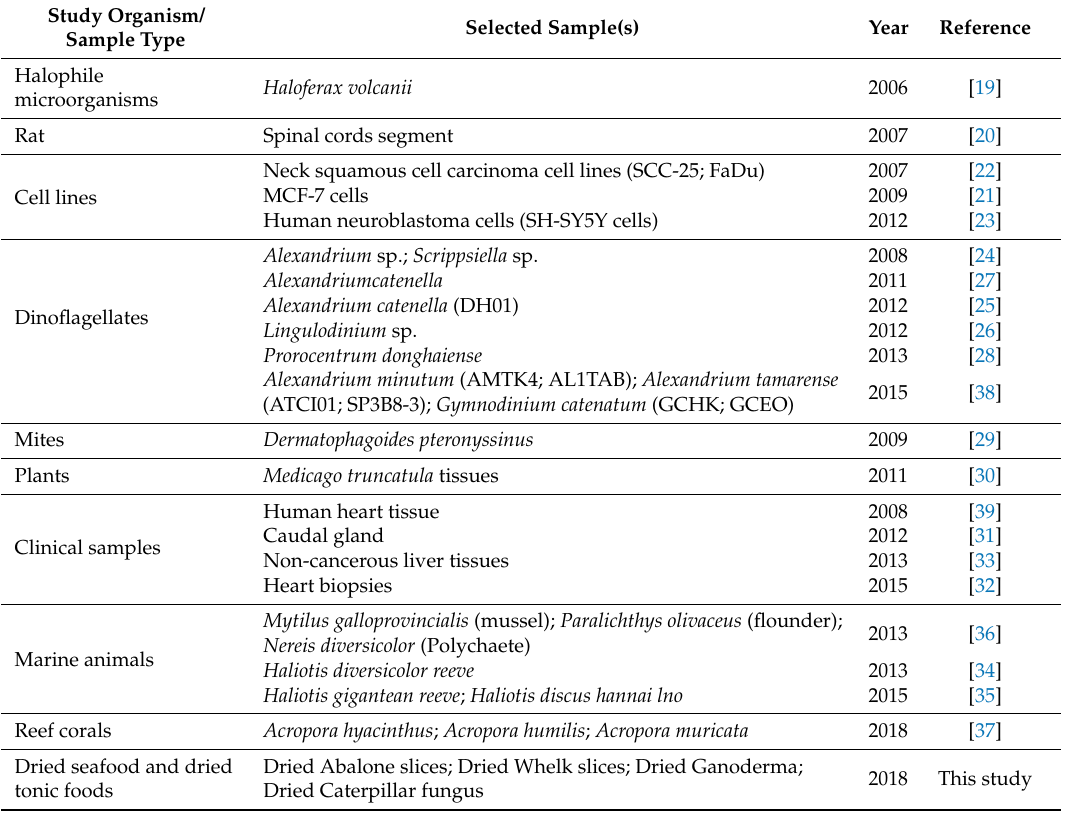
Table 1. Samples prepared by using TRIzol-based extraction method for high-quality two-dimensional gel electrophoresis